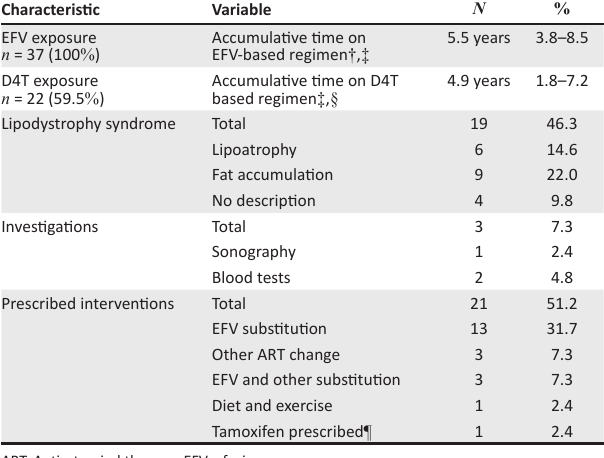
TABLE 4: Antiretroviral therapy exposure and adverse events for abnormal breast ( n = 41). Characteristic Variable N